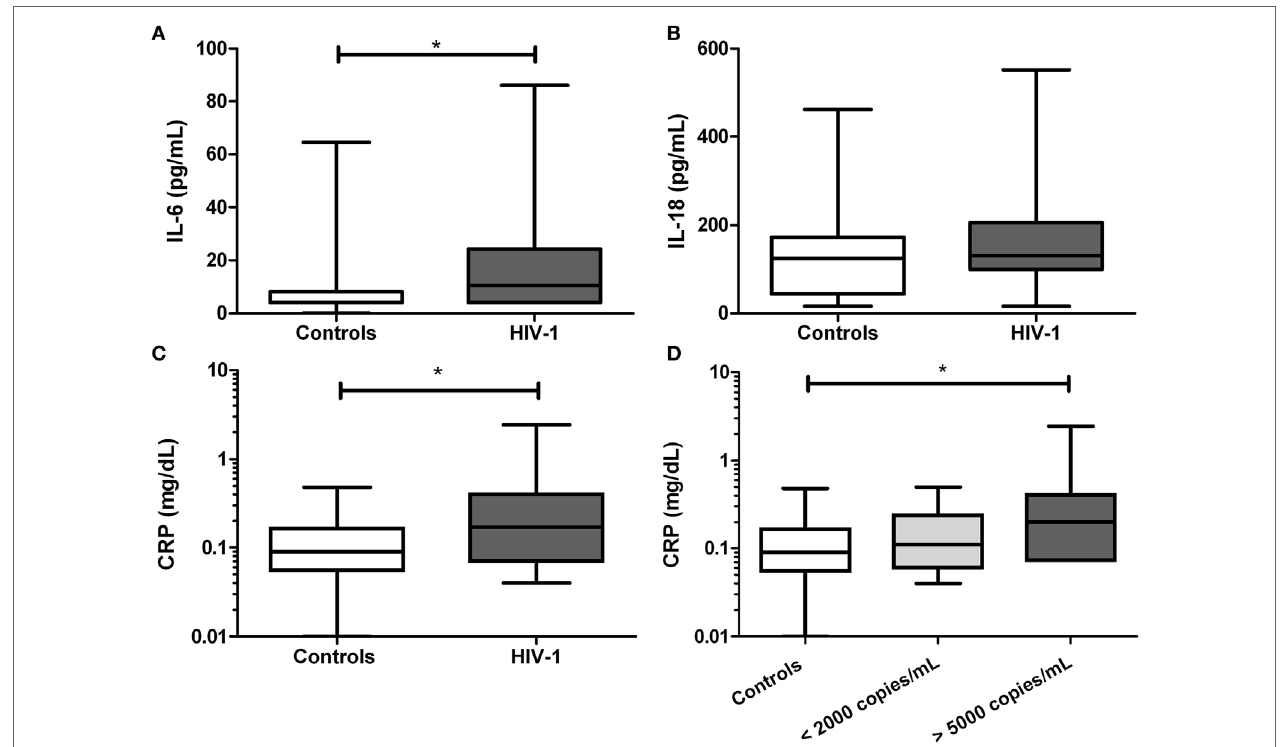
FigUre 4 | Serum levels of inflammatory markers in human immunodeficiency virus type 1 (HIV-1)-infected individuals. In serum samples from HIV-1-infected individuals and healthy controls were quantified (a) IL-6, (b) IL-18, and (c) C-reactive protein (CRP). In HIV-1-infected individuals, the CRP was compared according to viral load (D) . The statistical comparison was made using the Mann–Whitney U and Kruskal–Wallis tests with a 95% confidence level and post hoc tests (or multiple benchmarks) HDS of Dunn was made. Significant differences are represented in the upper part of this figure (* p <